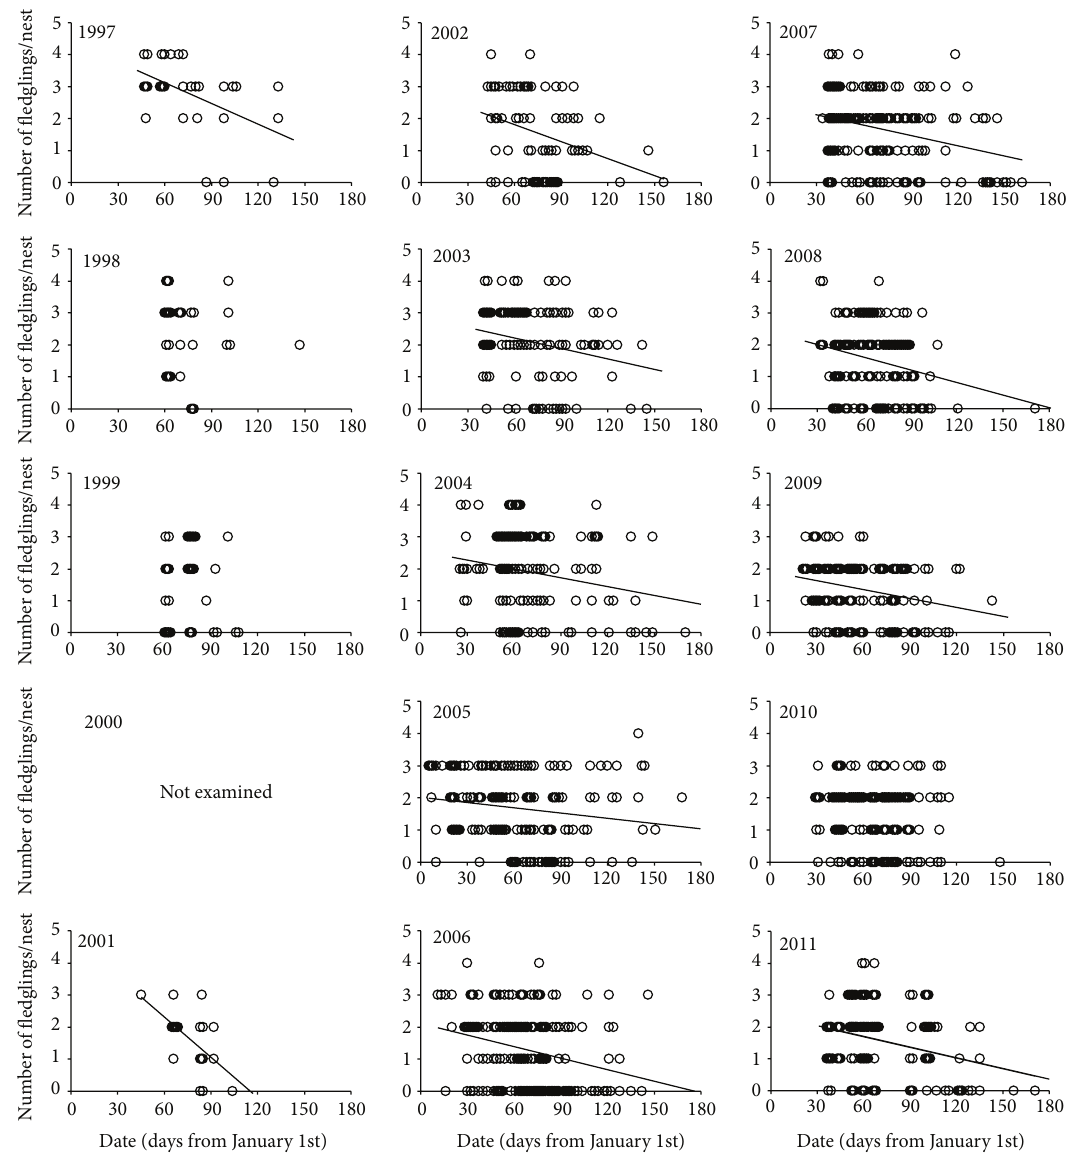
Figure 4: Number of fledglings per nest in relation to the date of the beginning of breeding in each nest. Regression lines are shown when the correlation coefficients are statistically significant (see Table